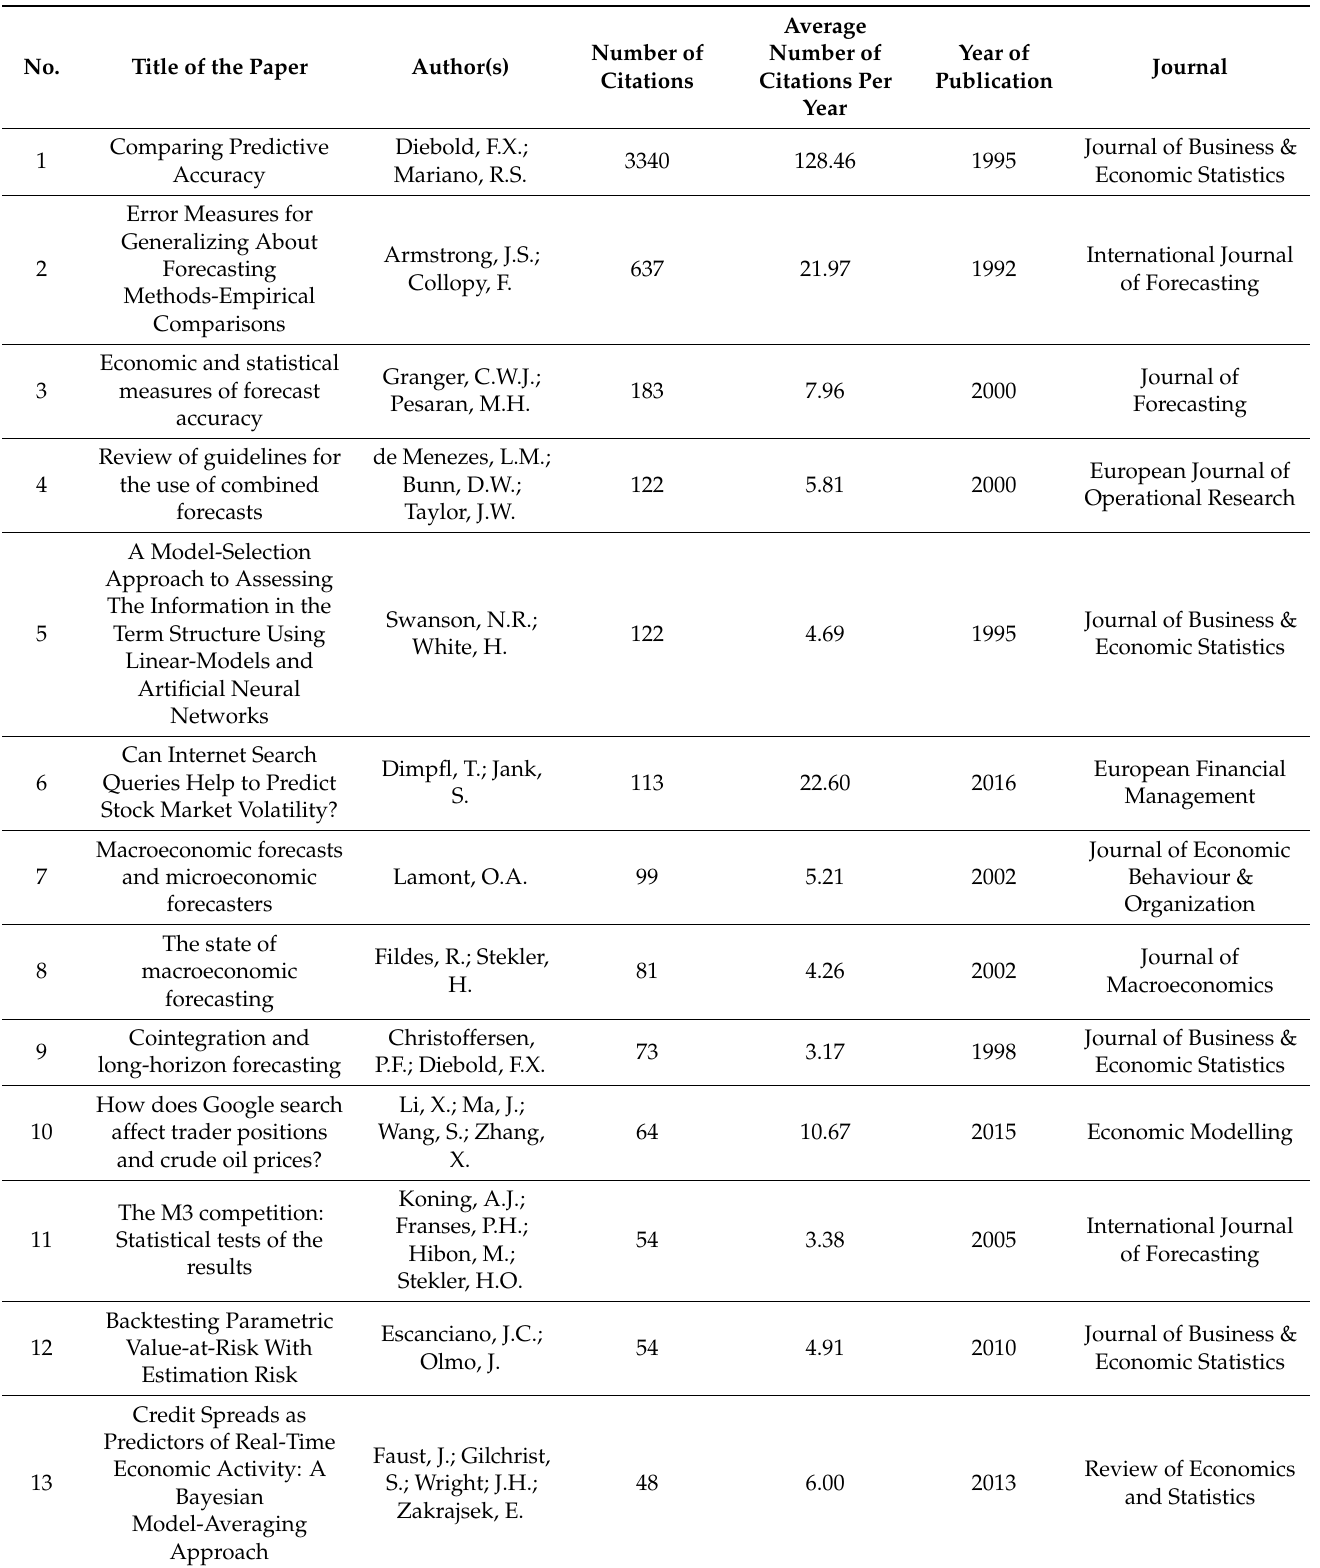
Table 5. Top 20 studies on “Measures on Economic Forecast